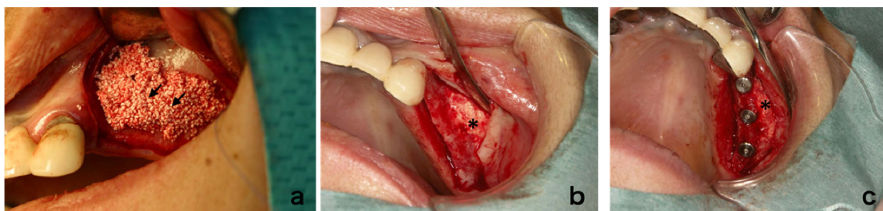
Figure 3 . Maxillary sinus floor augmentation: ( a ) operative procedure (arrows indicate the transplanted material), ( b ) regenerated alveolar bone 6 months after surgery, ( c ) dental implant insertion (asterisk indicates regenerated bone).